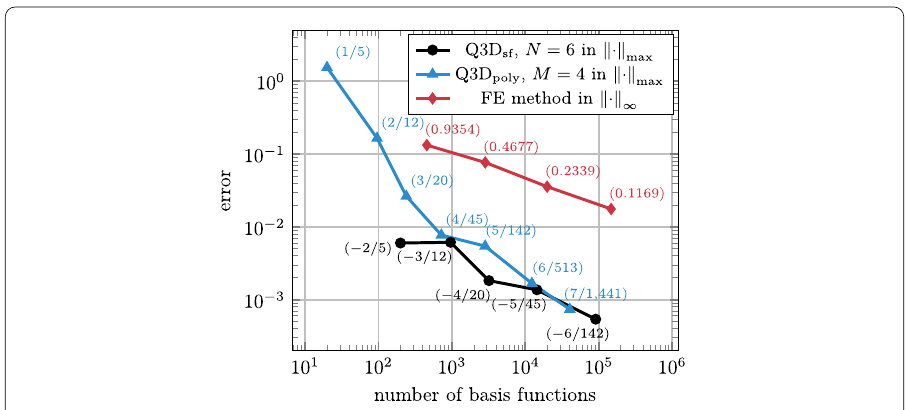
Figure 9 Error between analytical and numerical solution of Q3D sf method (black) and Q3D poly method (blue) and of a conventional 3-D FE method. The numbers between the paranteses are the scale and the number of FE nodes for Q3D sf , the number of elements and the number of FE nodes for Q3D poly and the longest edge length for the FE